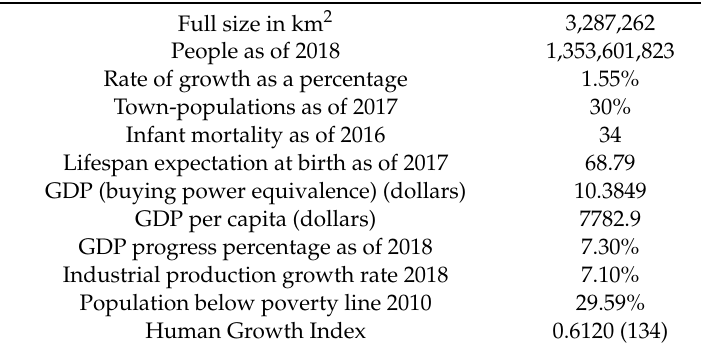
Table 8. Indian Social and economic status